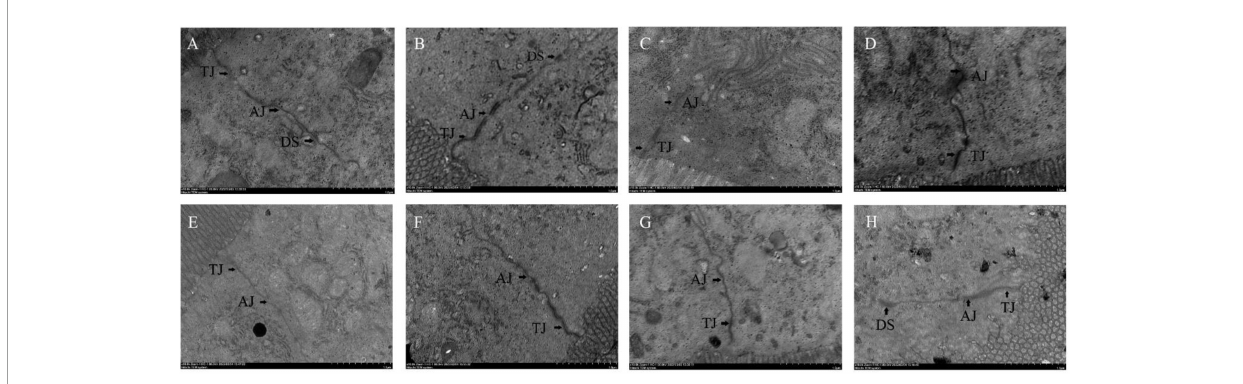
FIGURE5 Transmission electron micrograph of mouse ileal tissue. Panels (A–H) represents NC, CPM, CPC, EDC, EF, BS, LS, MC group. TJ: Tight Junction; AJ: Adhesive Junction; DS: